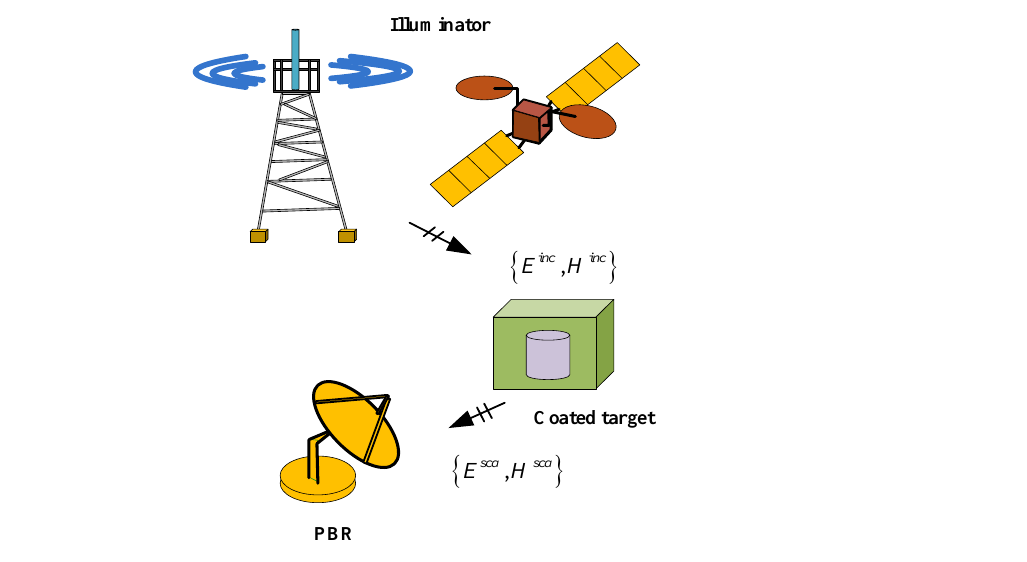
medium with parameters lectric coating with parameters represent the perfect elec- tric conductor, dielectric region, and background medium region. The surface of dielectric and perfect electric conductor is denoted by represents the electromagnetic parameters of c  . The target is excited by an incident wave that comes from a non-cooperative illuminator. n is the outward normal unit vector. By introducing the equivalent surface principles, two equivalent problems are formulated.